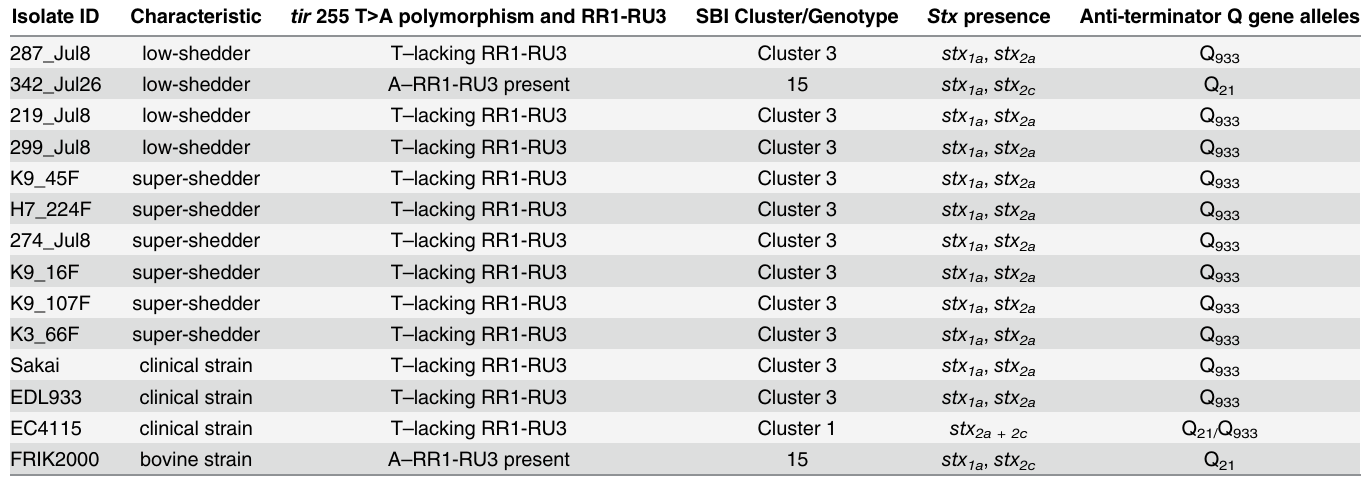
Table 2. Genetic characteristics among Escherichia coli O157:H7 isolates examined within this study and reference strains. Isolate